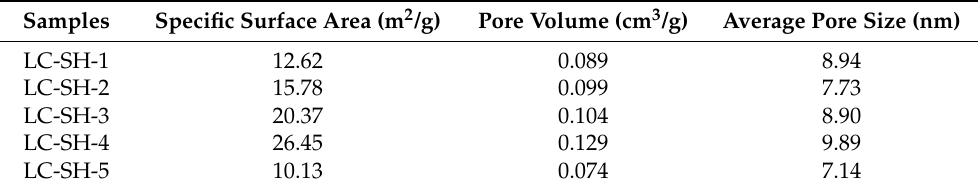
Table 2. BET results of catalysts with different amounts of